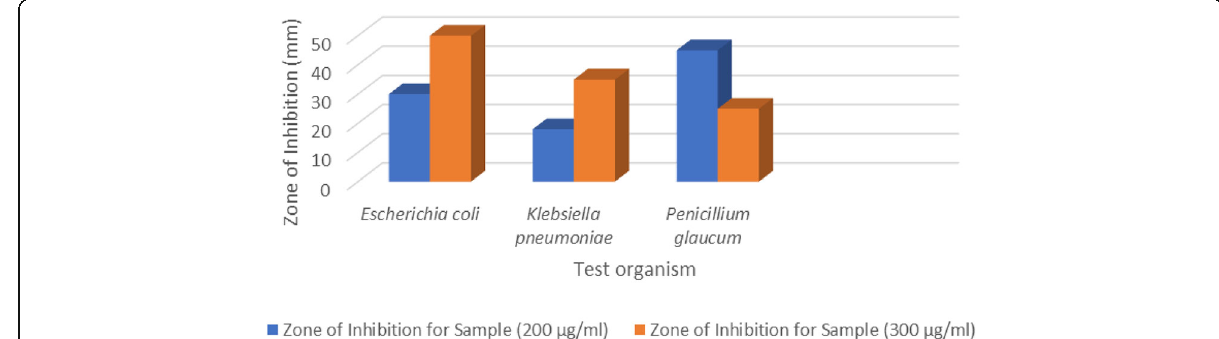
Fig. 5 Antimicrobial activities of Sterculia urens Roxb. root extract on various micro-organisms as determined by the agar well diffusion